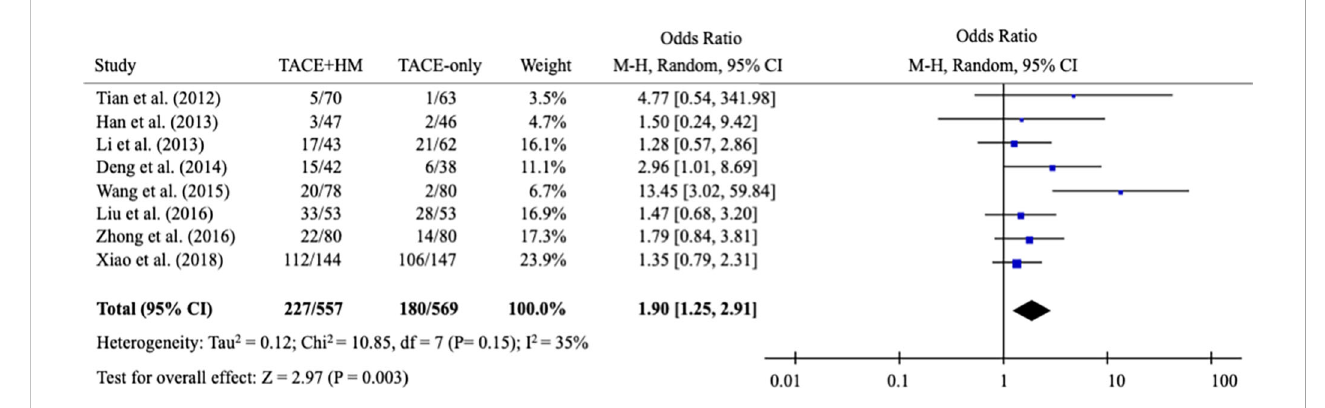
FIGURE 6 Meta-analysis of overall survival at 36-month.